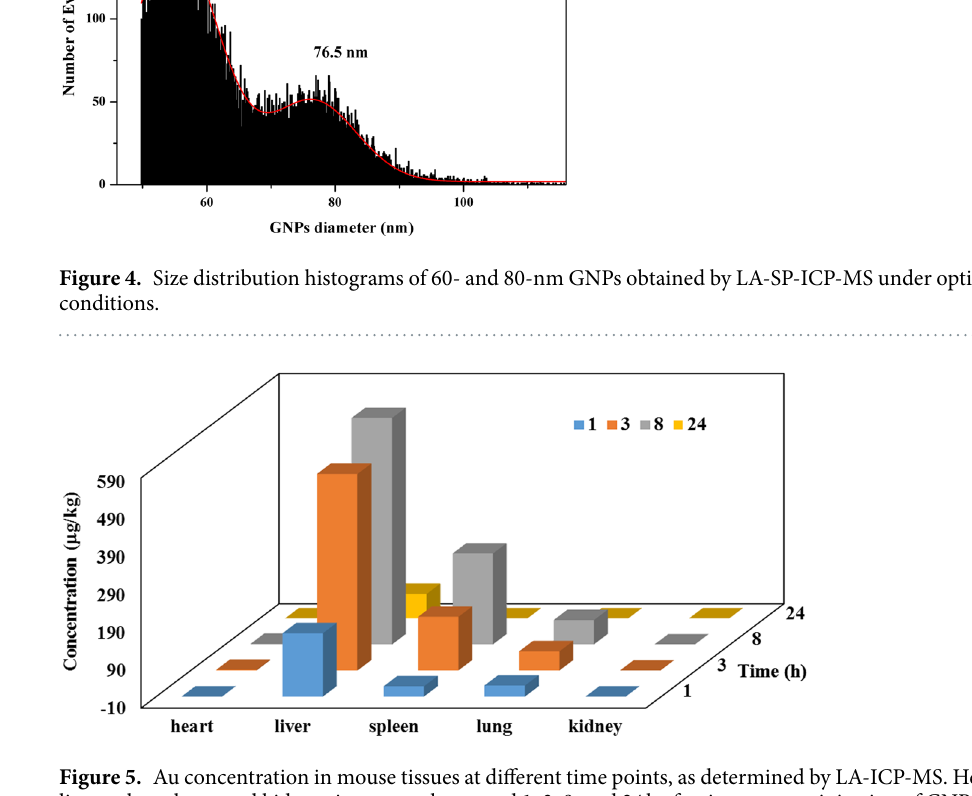
Figure 5. Au concentration in mouse tissues at different time points, as determined by LA-ICP-MS. Heart, liver, spleen, lung, and kidney tissue were harvested 1, 3, 8, and 24 h after intravenous injection of